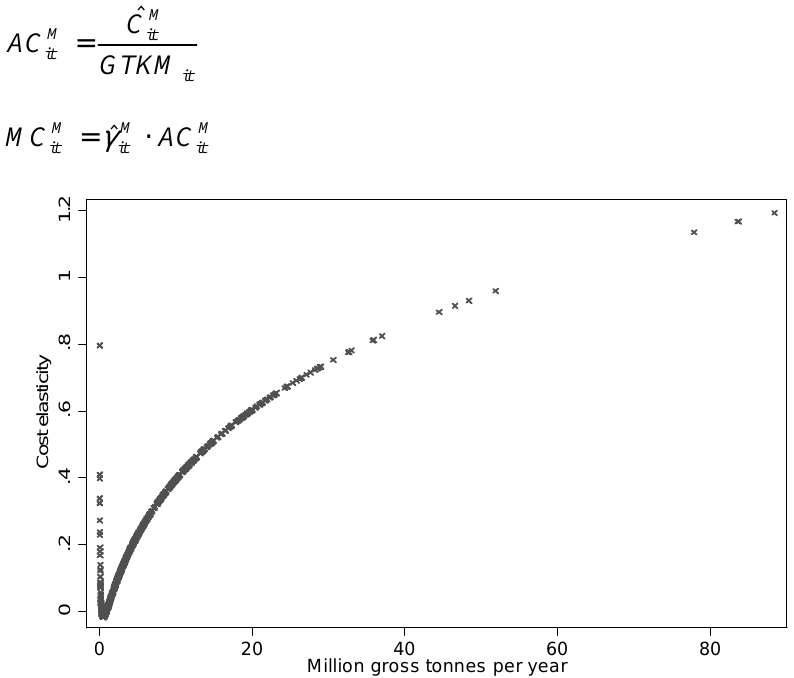
Figure 1. Maintenance cost elasticity with respect to output – Model I If we adjust the marginal cost and estimate a mean value taking individual traffic levels into account, we get a weighted marginal cost ( MC w ) for the entire network based on the traffic share per track section as in (12). This procedure generates a common marginal cost to all track sections and is revenue neutral compared to applying individual marginal costs to all track